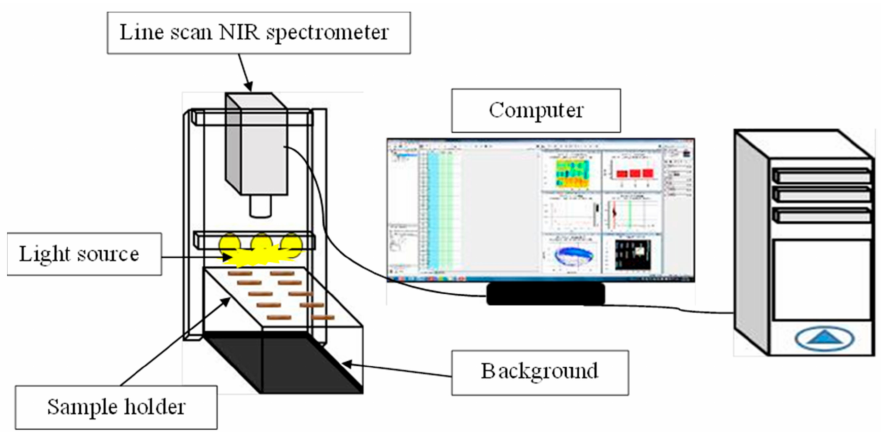
Figure 2. Apparatus of near infrared (NIR) hyperspectral imaging systems. After scanning, the relative reflectance (R) of the sample was then calculated as R sample − R dark [26], where R sample , R dark , and R white are the intensity reflectance of the sample, R white − R dark dark reference, and white reference, respectively. R was implemented for modelling, which is the independent